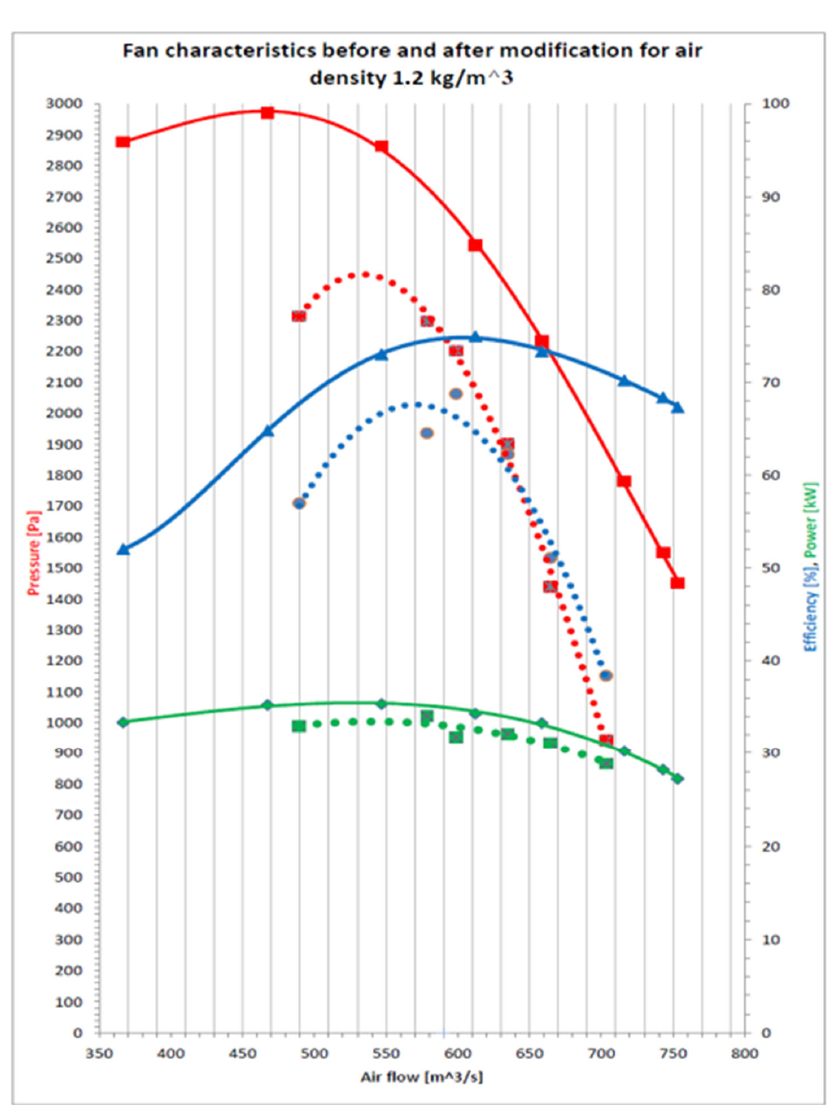
Figure 18. Balancing of the rotor.